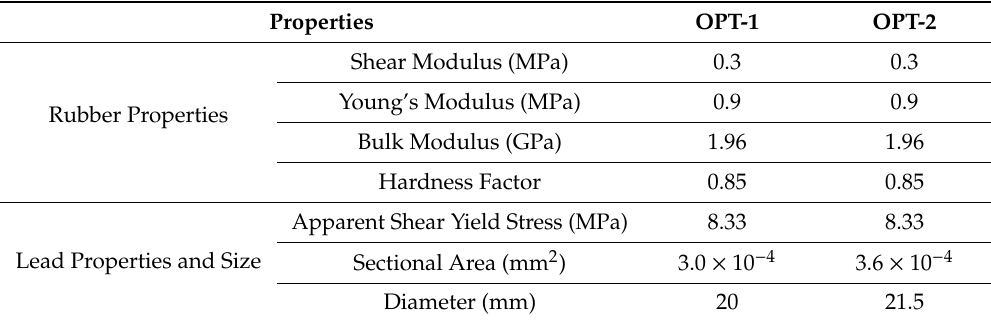
Table 1. Rubber properties and lead